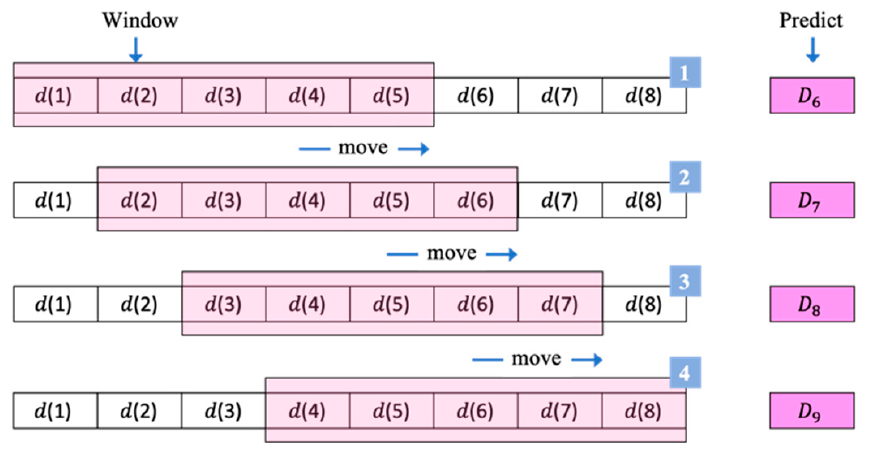
Figure 2. Sliding window of the γ ‐ Sutte indicator